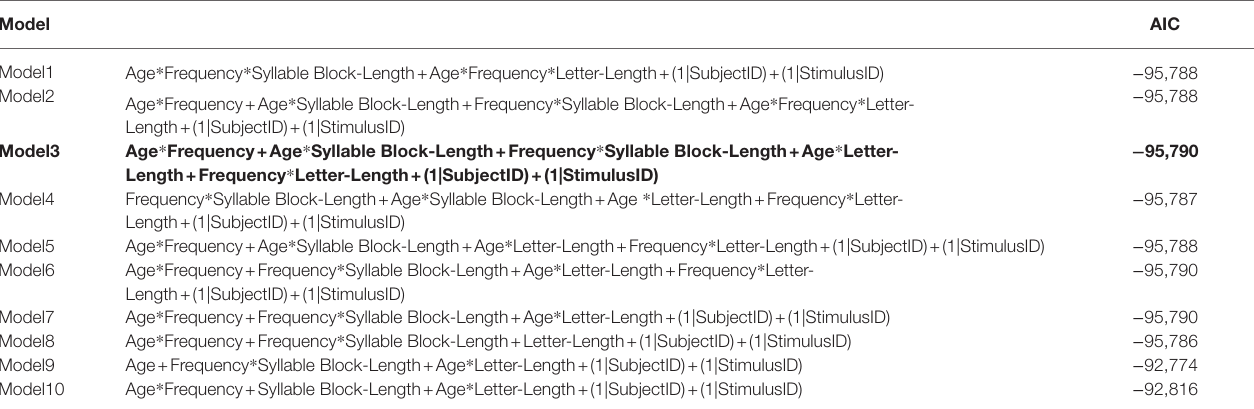
TABLE 8 | Comparison of mixed-effects regression models on reading latency: age × frequency × length on words (best-fitting model in bold). Model